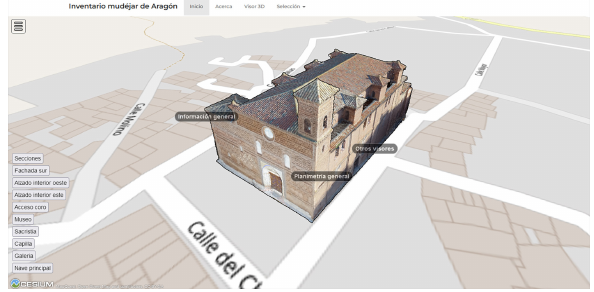
Figure 9. WebGL environment with the 3D point cloud of the Santa Mar´ıa church (Tobed, Spain) over the OpenStreetMap layer.